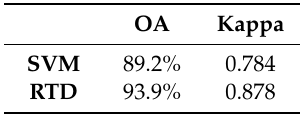
Table 8. OA and Kappa coe ffi cient of the SVM and RTD methods for the images from the Xinjiang area.